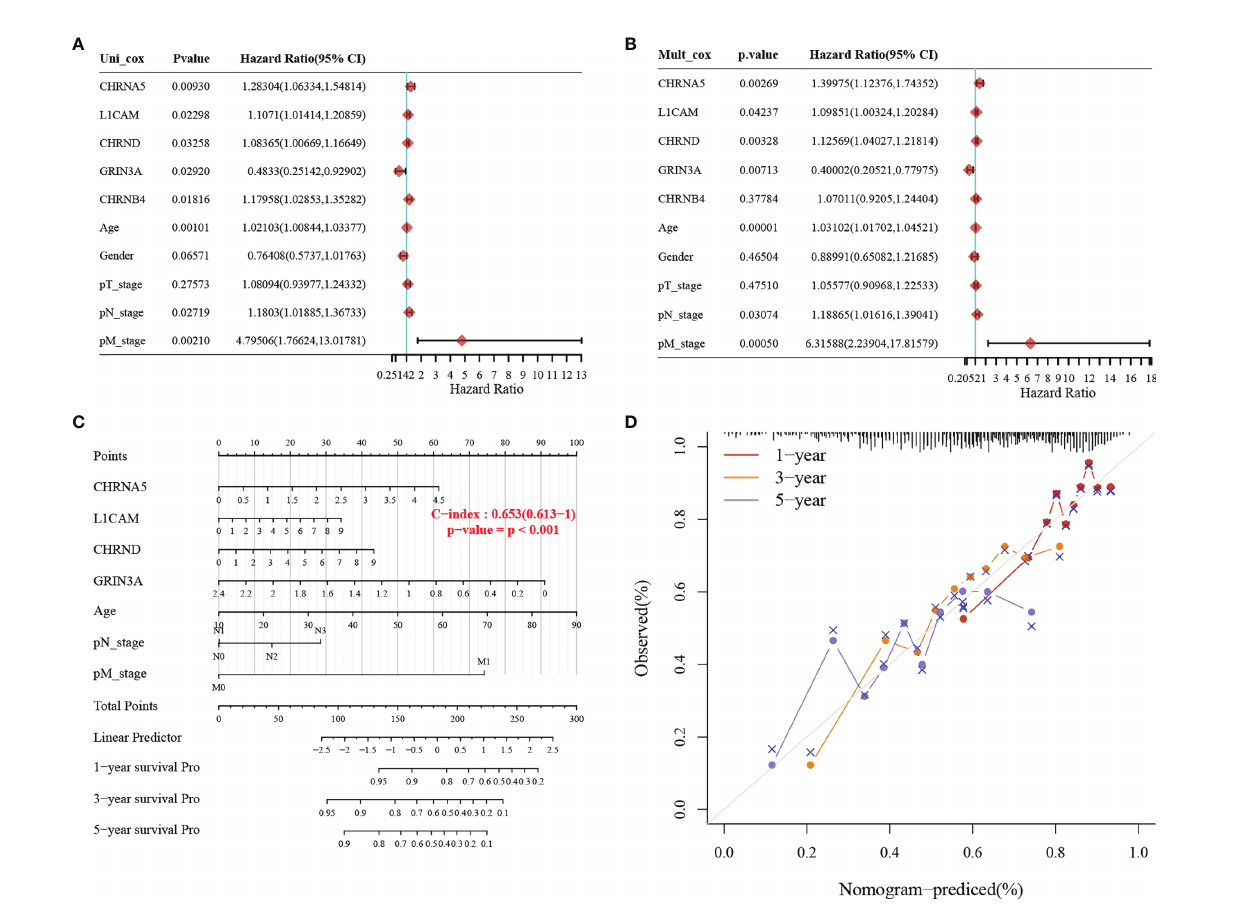
FIGURE 5 | Construction of a predictive nomogram. (A, B) Hazard ratio and p -value of the constituents involved in univariate and multivariate Cox regression considering clinically the parameters and seven prognostic NCCGs in HNSC. (C) Nomogram to predict the 1-, 3-, and 5-year overall survival rate of HNSC patients. (D) Calibration curve for the overall survival nomogram model in the discovery group. A dashed diagonal line represents the ideal nomogram. NCCGs, nerve-cancer cross-talk genes; HNSC, head and neck squamous cell